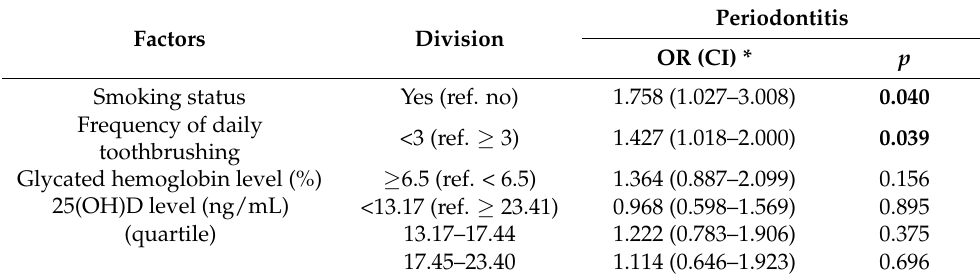
Table 2. Factors associated with periodontitis based on multiple logistic regression